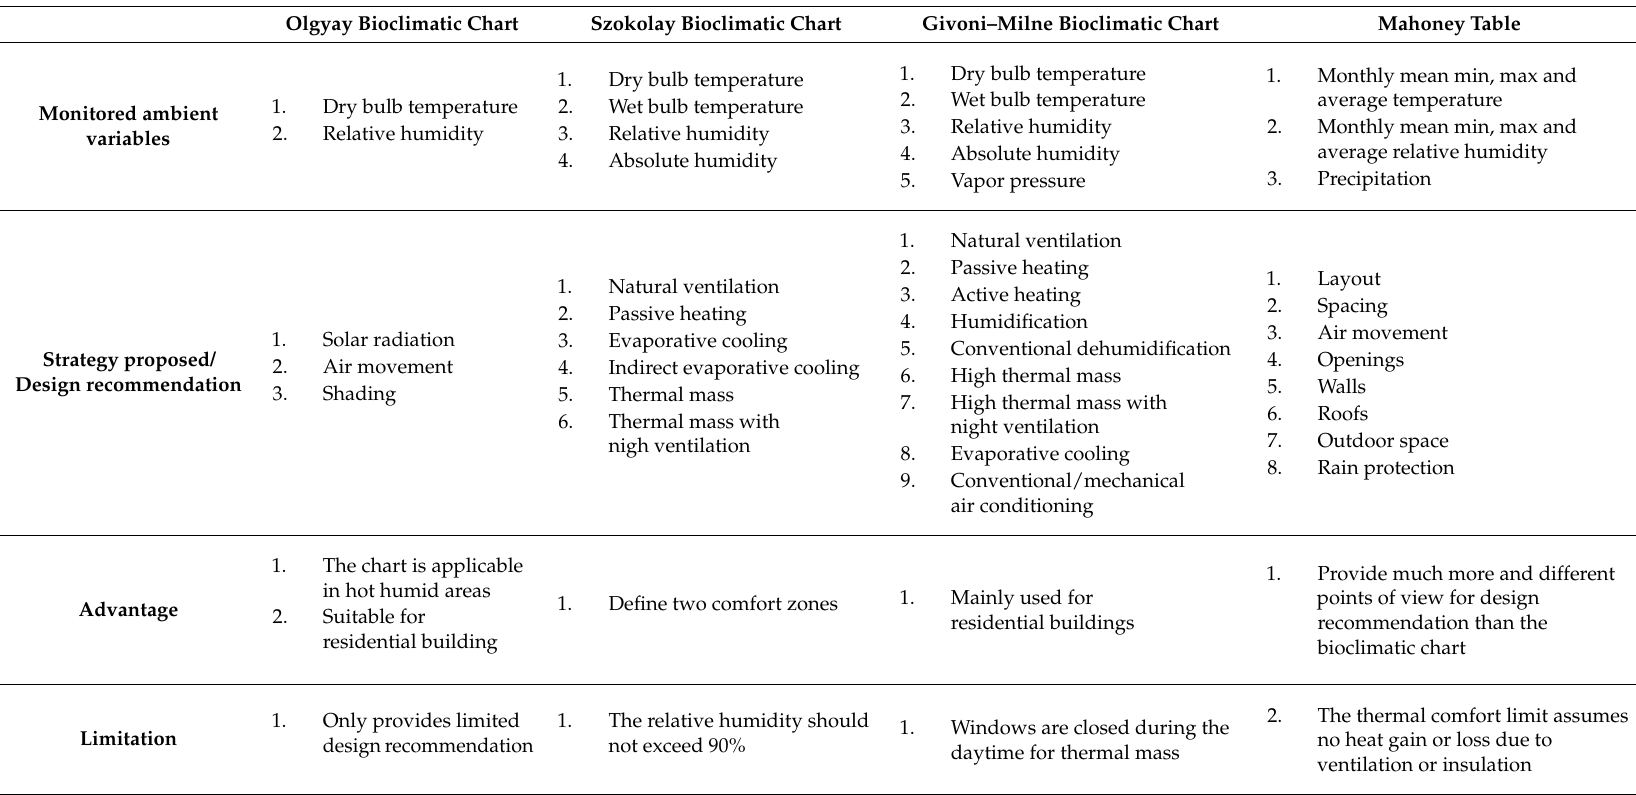
Table 1. Summary of climatic analysis tools for building design